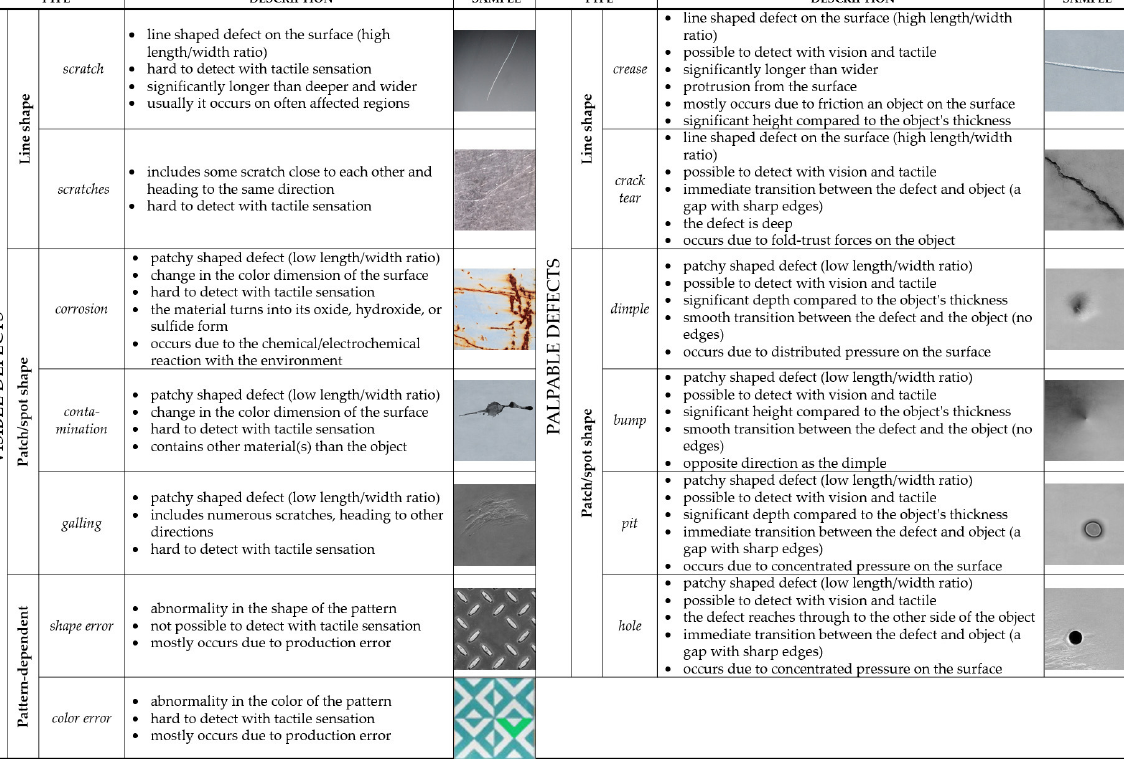
Figure 2. The category of visible defects contains defects that are hard or almost impossible to be localized by touch. The category of palpable defects contains defects that are significantly easier to be localized with the combination of vision and touch. Clearly, the naming of categories does not mean that there are no exceptions in either